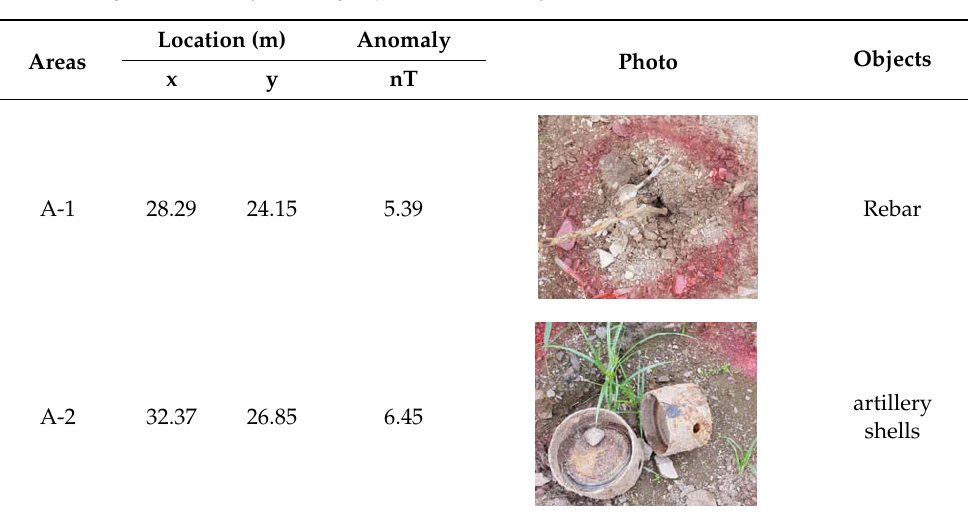
Table 2. Magnetic anomaly-causing objects identified by the EOD.